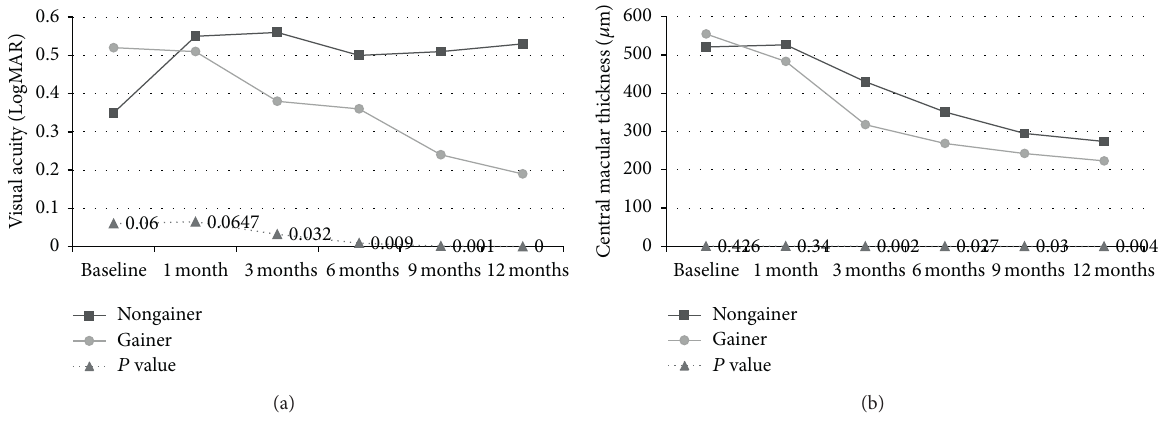
Figure 2: The change of Visual acuity and central macular thickness. (a) Visual acuity and (b) central macular thickness.